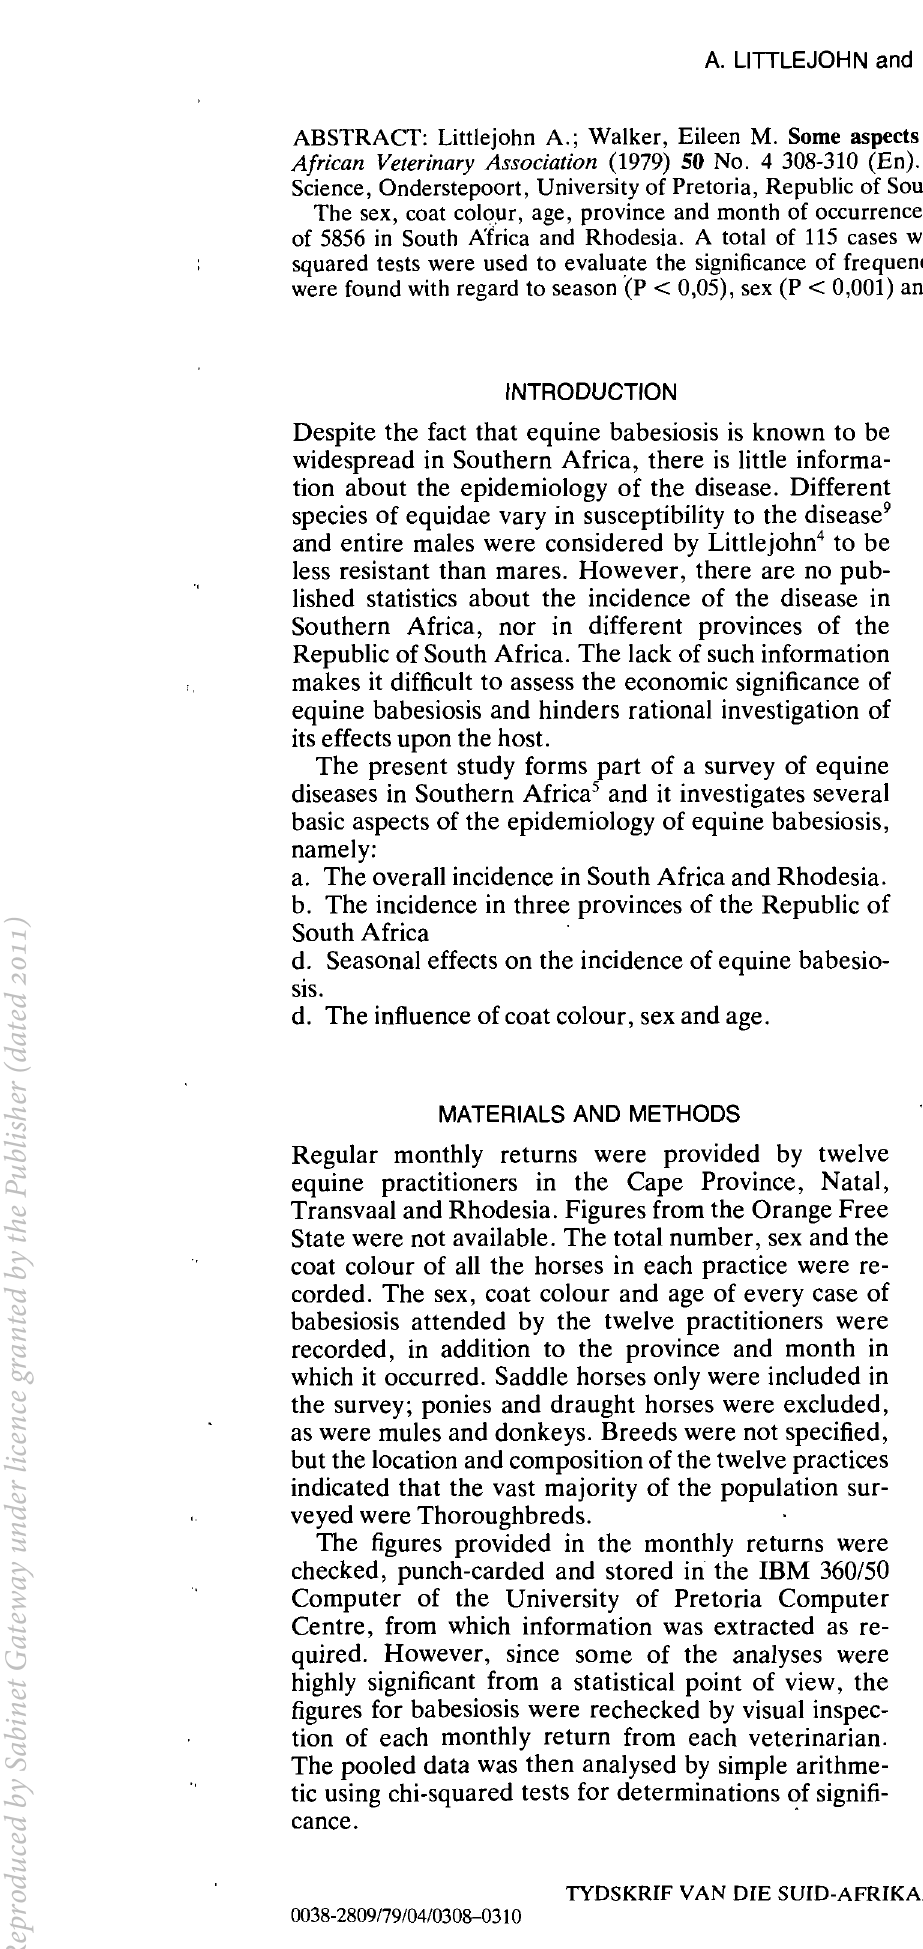
Fig. 1. The incidence of equine babesiosis in Rhodesia and South Africa in 1973.